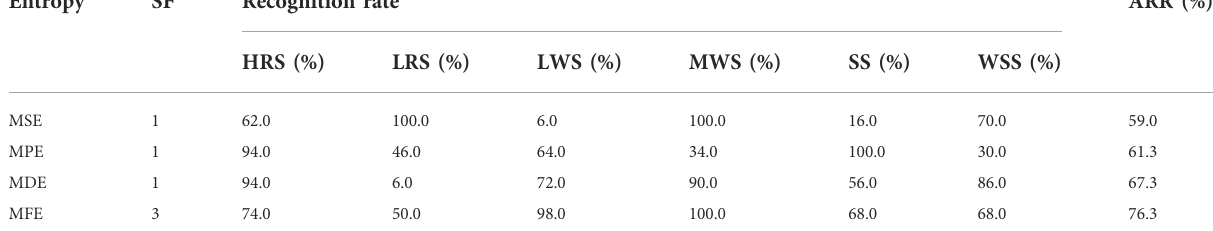
TABLE 2 The highest ARR of a single feature for six